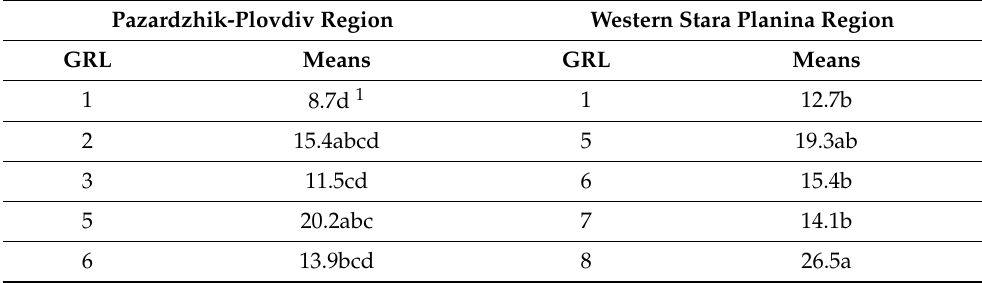
Table 3. Effect of groups of land use types on the plant diversity in the two regions of study, when the mean number of species per scoring plot was considered as depending variable (tested by one-way